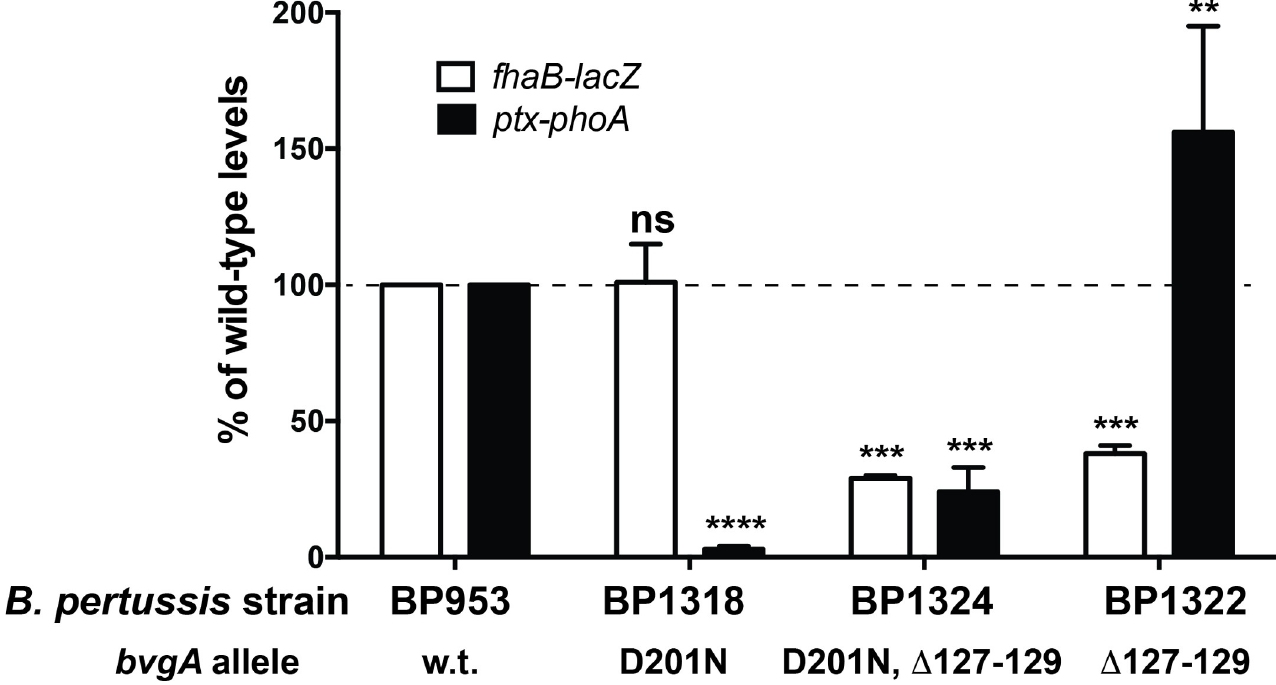
Fig 1. Activity of gene fusions in BP953 and derivatives. BP953 contains two transcriptional fusions, fha-lacZ and ptx-phoA . The results of beta-galactosidase and alkaline phosphatase enzymatic assays are shown, with w.t. values set to 100% for comparison. Also shown are the results of assays of the derivatives, BP1318, BP1324, and BP1322 harboring the bvgA alleles indicated, normalized to those for BP953. Isolation of these alleles is described in the text. Values were normalized to fha-lacZ and ptx-phoA expressed in BP953 and data from at least four assays were used in the calculation of means, standard deviations, as indicated by error bars, and statistical analysis by one-way ANOVA. Outcomes of the latter analysis are presented using the symbols: ns, P > 0.05; �� , P � 0.01; ��� , P � 0.001; ���� , P � 0.0001.